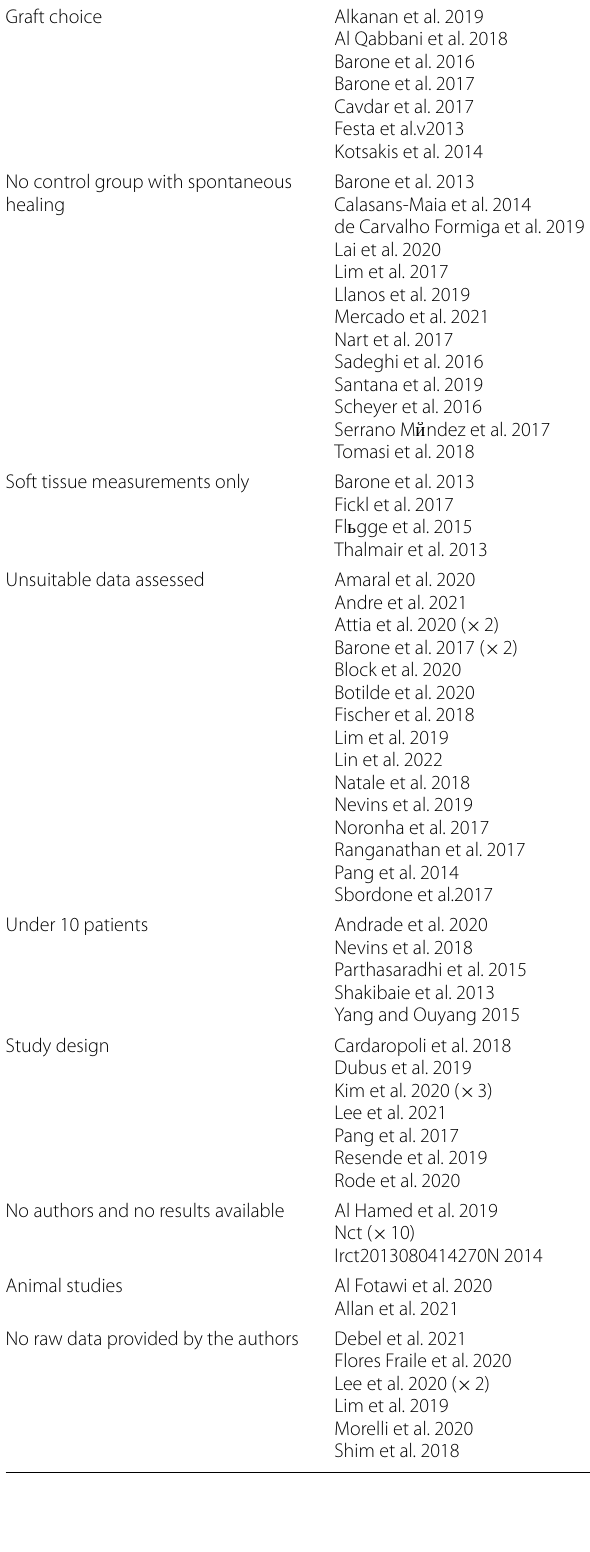
Table 2 Excluded studies sorted according to the reason of exclusion at full-text screening ( n =